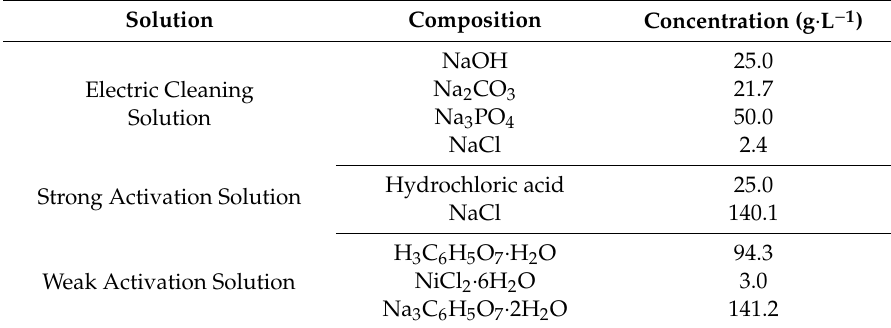
Table 1. Composition of the solution used in the pretreatment experiment.